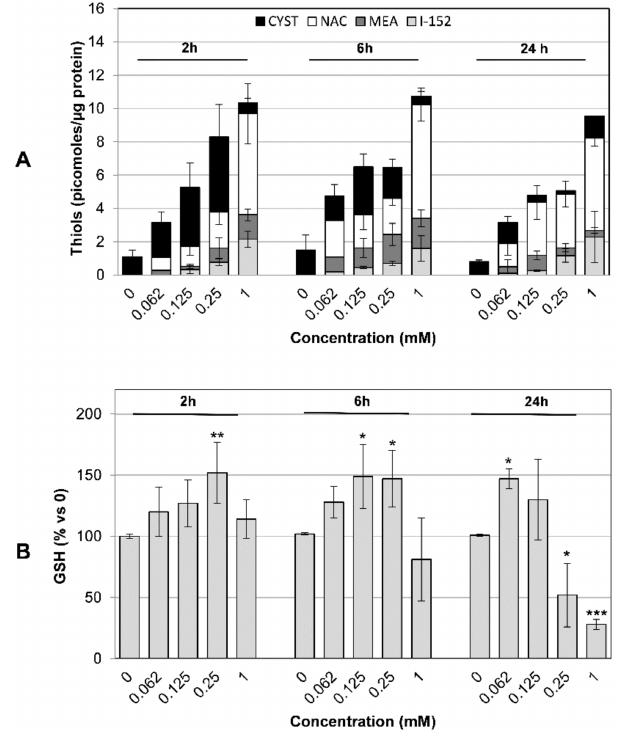
Figure 6. Thiol species in I-152 treated cells. MEA, NAC, I-152, cysteine ( A ) and GSH ( B ) content in RAW 264.7 cells treated with different concentrations of I-152 for 2, 6, and 24 h. After incubation, cells were washed and lysed; the lysate was then treated with precipitating solution and centrifuged. Thiol species and GSH levels were determined in the lysate supernatant by HPLC, while protein content was quantified spectrophotometrically in the lysate pellet. Quantification of thiol species was obtained by injection of standards of known concentrations and values were normalized on protein concentration. GSH content is expressed as the percent of the value obtained in untreated cells (0). Values are the mean ± SD of five independent experiments. * p < 0.05; ** p < 0.01, *** p <